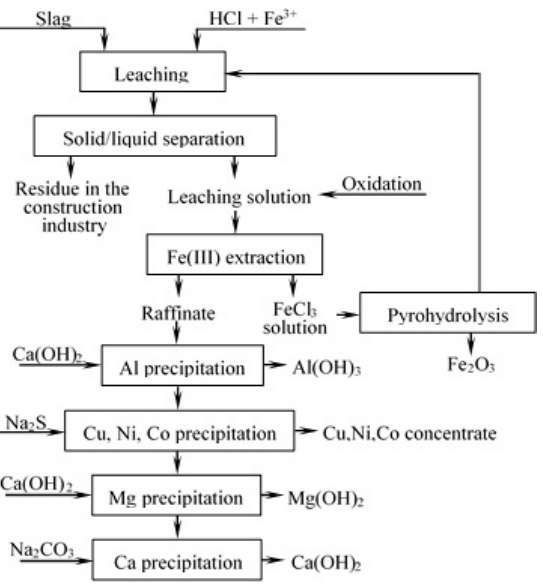
Figure 12. A conceptual flow sheet for leaching of slag with HCl.